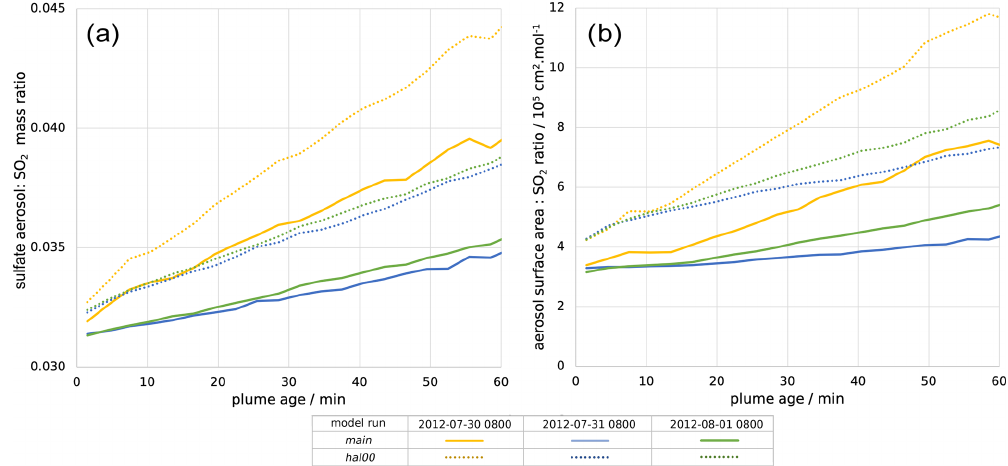
Figure 7. (a) Mass ratio of sulfate aerosol to SO 2 within the plume and (b) ratio of the total in-plume aerosol surface area to SO 2 concentra- tion, both plotted against plume age for 08:00UTC for 30 July 2012 (yellow), 31 July 2012 (blue), and 1 August 2012 (green). Solid lines are for the main model run; dotted lines are for the hal00 run; see Table 2.